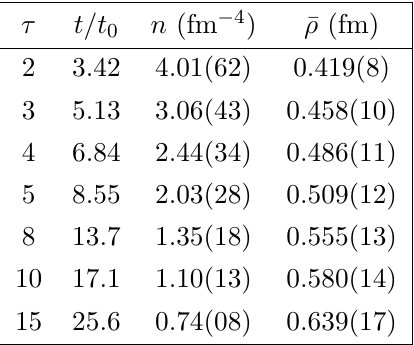
Table 2 . Instanton density and size for di(cid:11)erent Gradient (cid:13)ow times in lattice units ((cid:12)rst row) and in physical units in terms of t 0 =0.01125 fm 2 , obtained from the localization technique. The errors quoted for the instanton density include an estimate of the systematic uncertainty associated to the short distance (cid:12)lter (see text) while the average size errors are purely